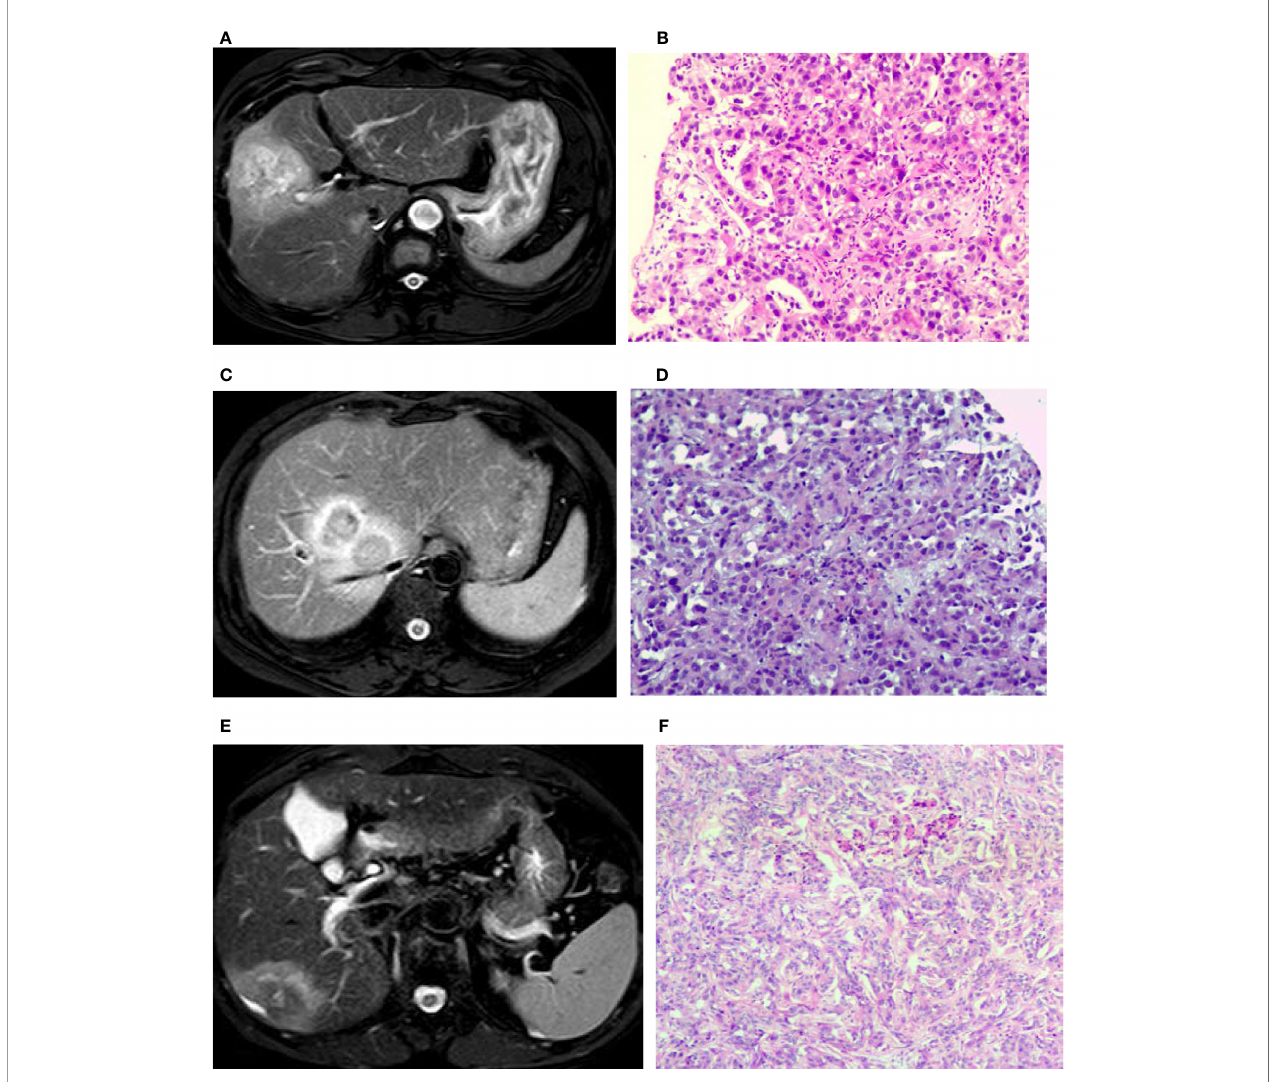
FIGURE 2 | T2 weighted imaging (T2WI) of intrahepatic mass-forming cholangiocarcinomas (IMCCs) with different differentiations. (A, B) A target sign was shown in a poorly-differentiated IMCC lesion on T2WI image with centrally relatively-hyperintense signal. (C, D) A target sign was shown in a poorly-differentiated IMCC lesion on T2WI image with peripherally relatively-hyperintense signal. (E, F) A target sign was shown in a moderately-differentiated IMCC lesion on T2WI with peripherally relatively hyperintense signal. Pathological staining: